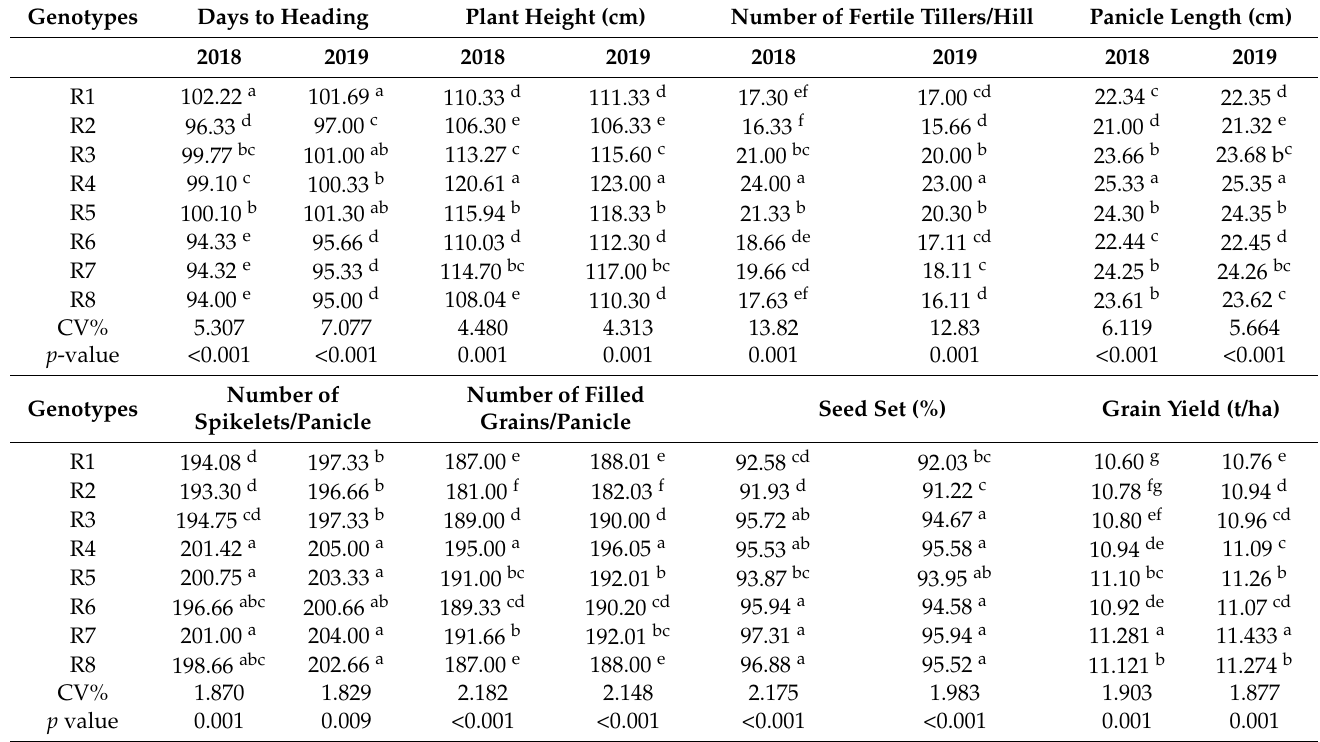
Table 3. Agronomic performance of the restorer lines and their parental cultivars during the 2018 and 2019